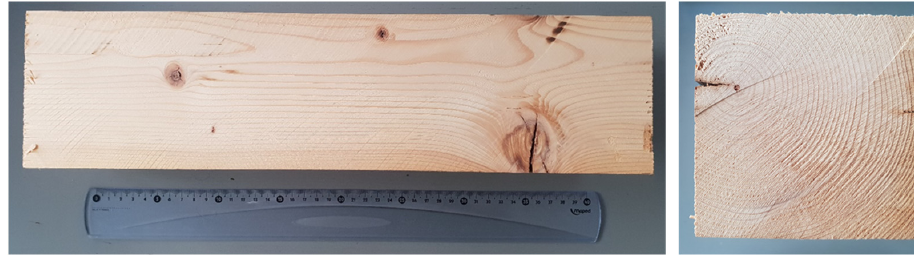
Figure 18. View of the prism-shaped sample finished for material density testing.